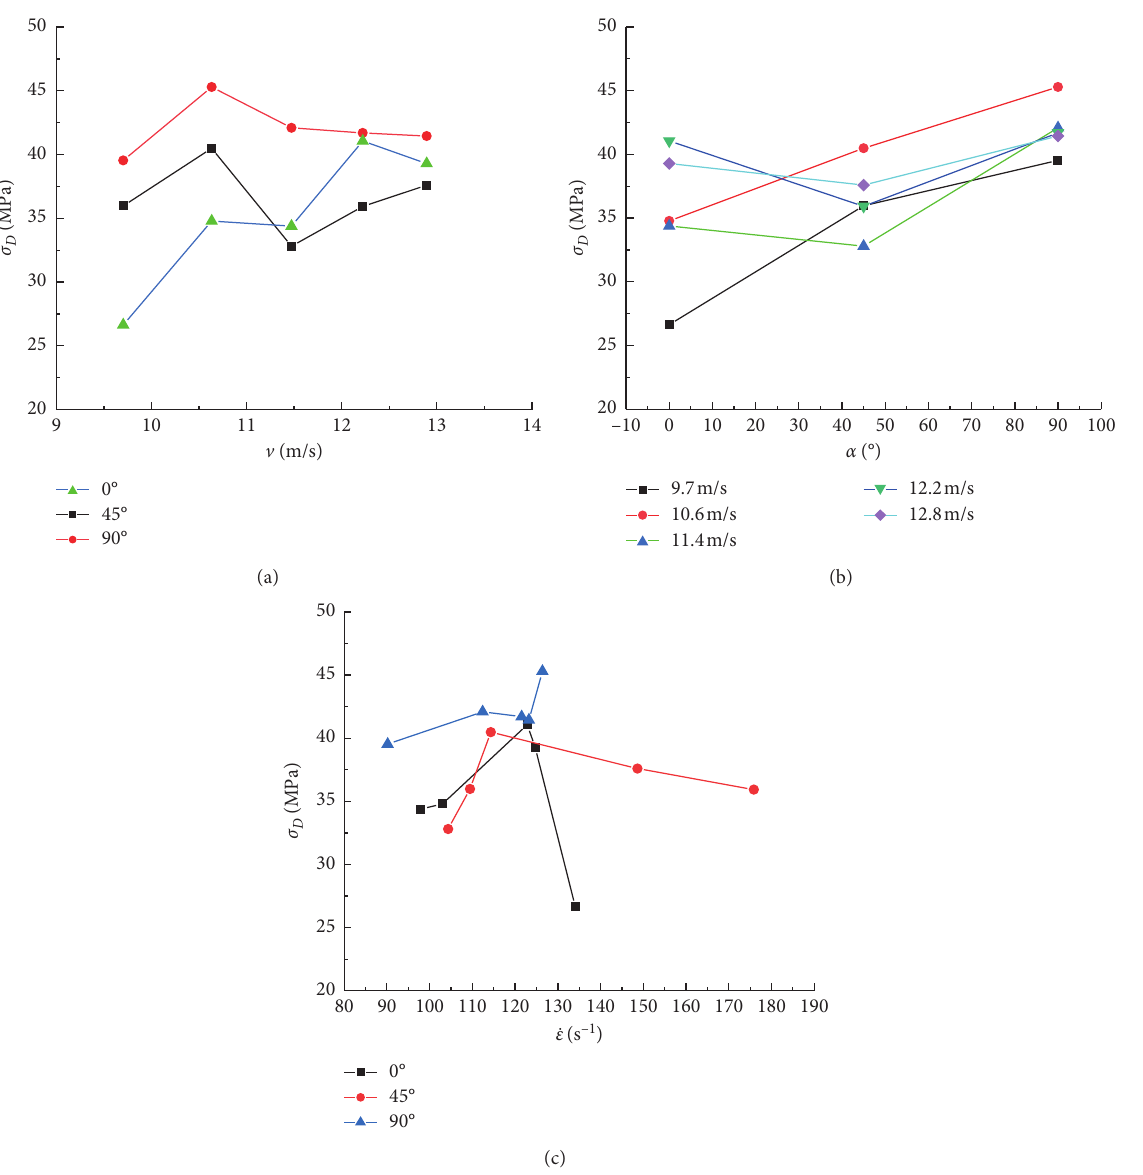
Figure 7: Relationship curves between dynamic compressive strength and loading rate, prefabricated fracture angle, and strain